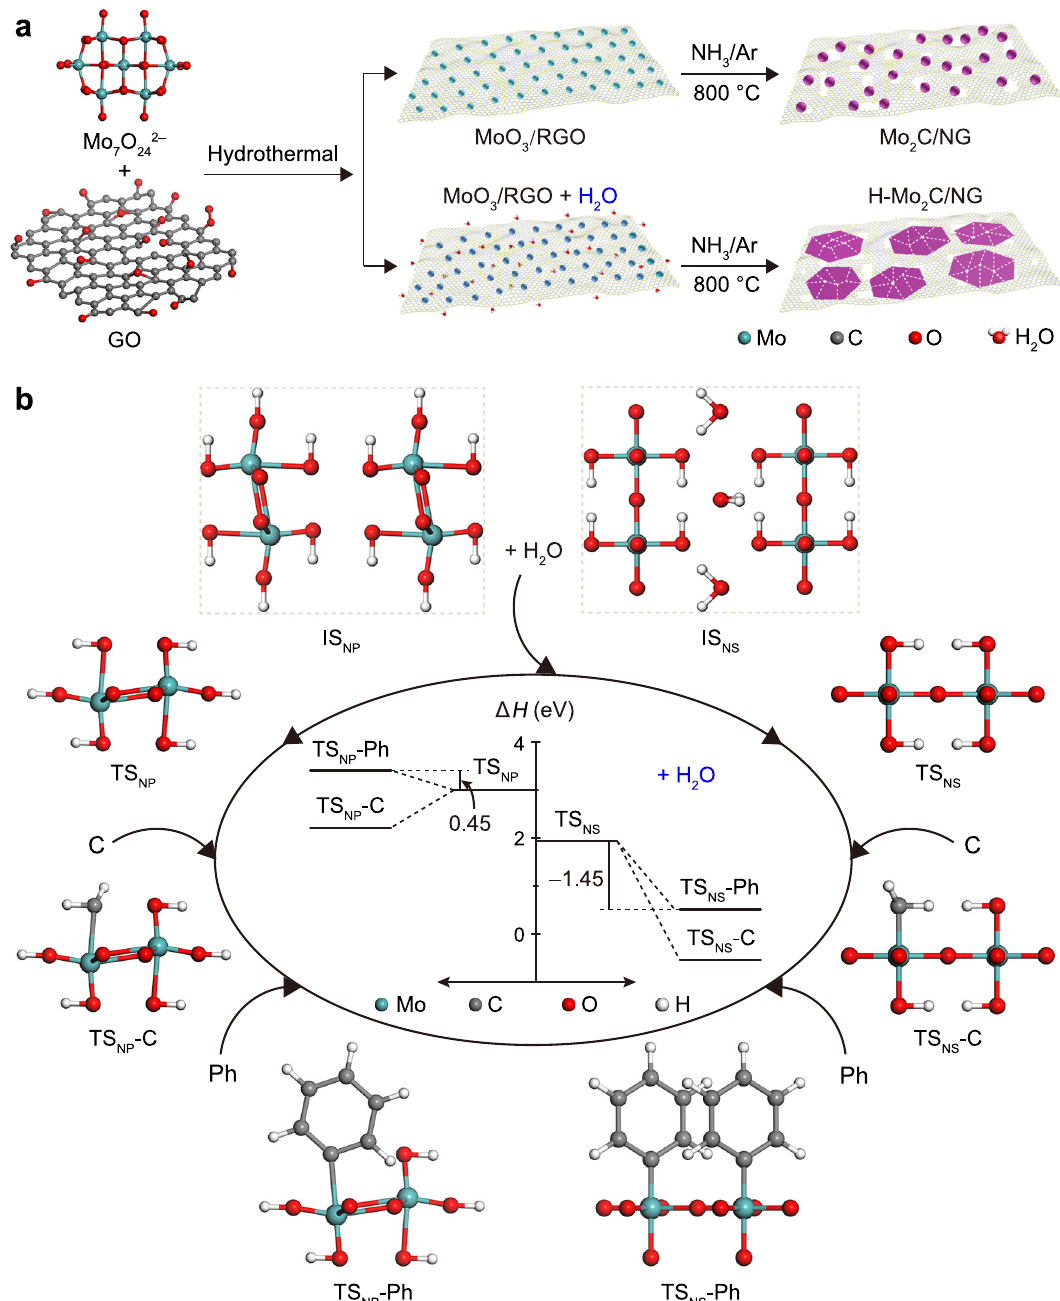
Fig. 1 | Formation of H-Mo 2 C/NG. a Schematic diagram of the synthesis of Mo 2 C/ NG and H-Mo 2 C/NG. b Various reaction states of IS NP and IS NS along the reaction pathway. Inset shows thecorresponding reaction Δ H diagram. The reaction Δ H for